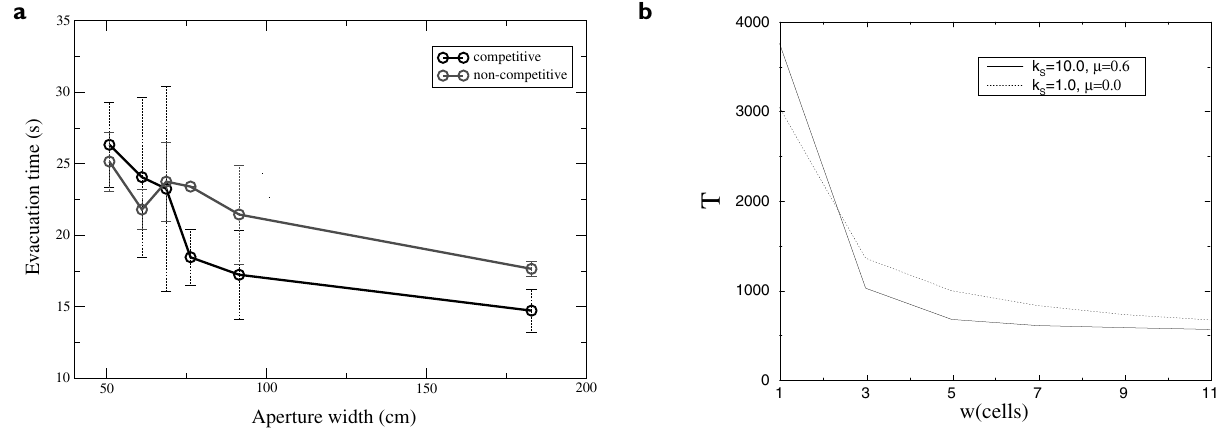
Figure 9 (a) Experimental results for evacuation times for an aircraft with variable door width for competitive and non-competitive behaviour of the passengers. (b) Results from computer simulations of the cellular automaton